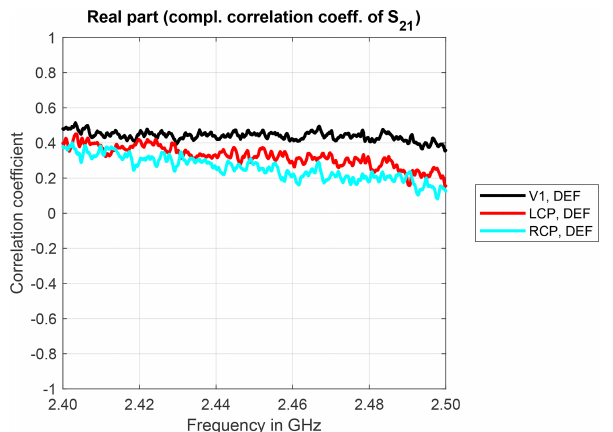
Figure 11. Real part of the complex correlation coefficients for dif- ferent antennas and measurement trial